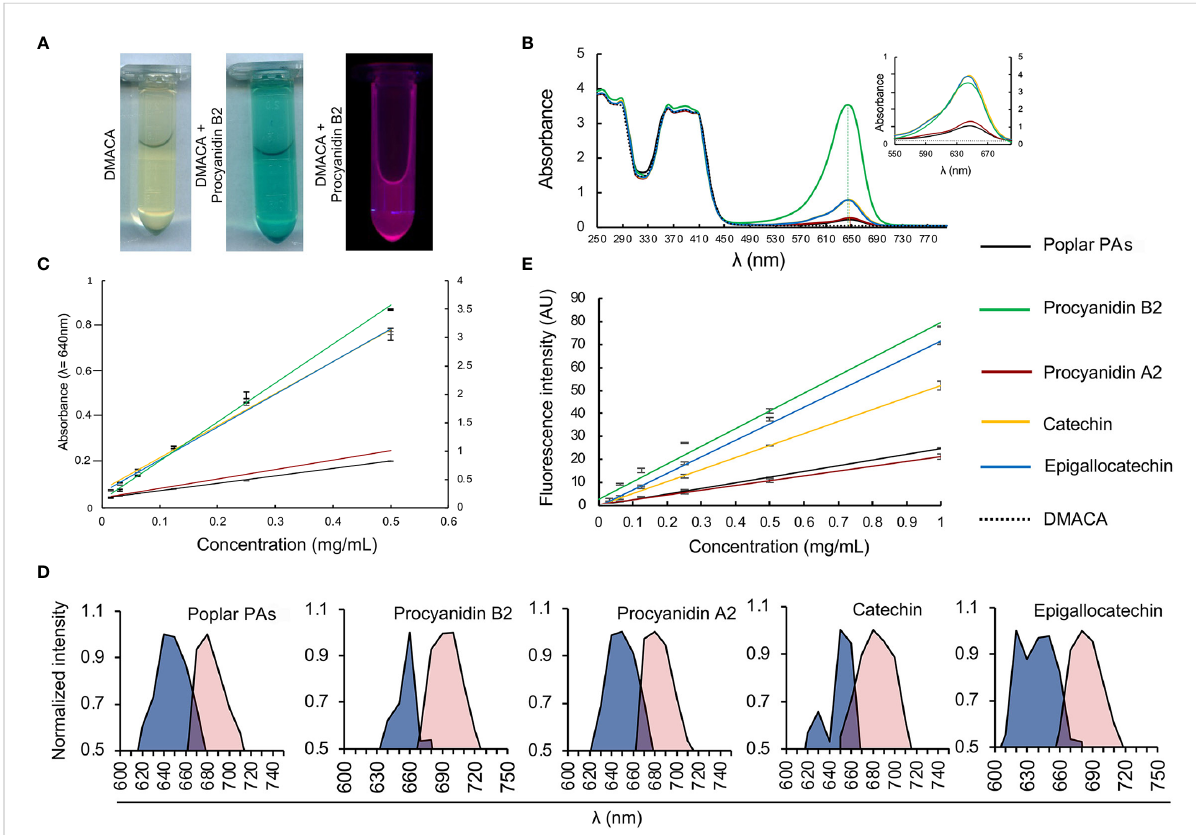
FIGURE 1 DMACA fl uorogenic properties. (A) DMACA yields blue precipitates in the presence of PAs (in this example with procyanidin B2, tube in the centre), which emits fl uorescence in a fl uorometer (purple, tube furthest to the right). (B) In a spectrophotometer, DMACA alone has absorbance peaks at 250 ± 20 nm and 390 ± 30 nm. In the presence of PA species, (procyanidin A2, B2, catechin, epigallocatechin, and poplar PA-extract), the DMACA absorbance spectrum exhibits a characteristic additional peak at 650 ± 40 nm. The position of peak maxima are indicated by vertical dashed lines. In the inset in (B) as well as in (C) the primary Y axis to the left of each graph applies to Procyanidin A2, Catechin, Epigallocatechin, and the poplar PA-extract and the secondary Y axis on the right applies to Procyanidin B2 for better visualization without overlapping curves. (C) PA quanti fi cation using a standard curve at 640nm with data from (B) . (D) In the fl uorimeter, DMACA-bound excitation spectra (blue area) and emission spectra (red area) differ among PA species. (E) DMACA fl uorescence data ( l ex = 650 nm, l em = 690 nm, cutoff fi lter 665 nm) can be used for quanti fi cation of PA